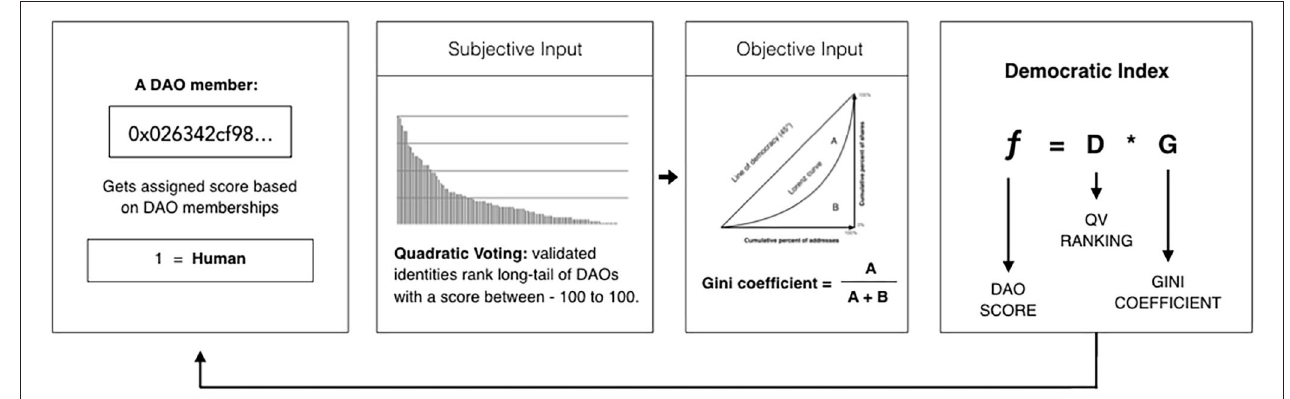
FIGURE 2 | Step 1: Every address that belongs to a DAO will be weighted by the Equality protocol with a percentage of the Democratic Index obtained from the intersection of DAOs that constitute the identity of such address. Step 2: In order to counterweight false positives on the Gini Coefficient, addresses that achieve a high score will be granted the right to rank the different DAOs analyzed by the Equality Protocol oracle, according the their corresponding ability to ensure that no single Human controls more than one identifier within its domain. Step 3: The Gini coefficient for the democracy ranges from 0 to 1, with 0 representing perfect totalitarianism and 1 representing perfect democracy. It computes a score that measure the share distribution by each segment of addresses belonging to a DAO. Step 4: A Democratic Index is calculated for each DAO, as a function of their position in the Quadratic Voting rank and their Gini Coefficient.